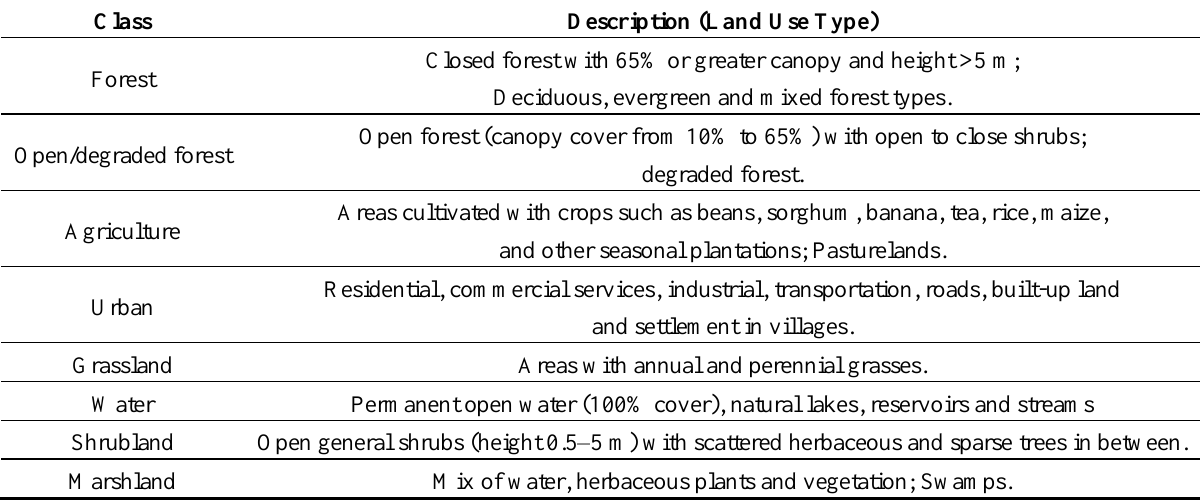
Table 3. Description of the land cover classes for this